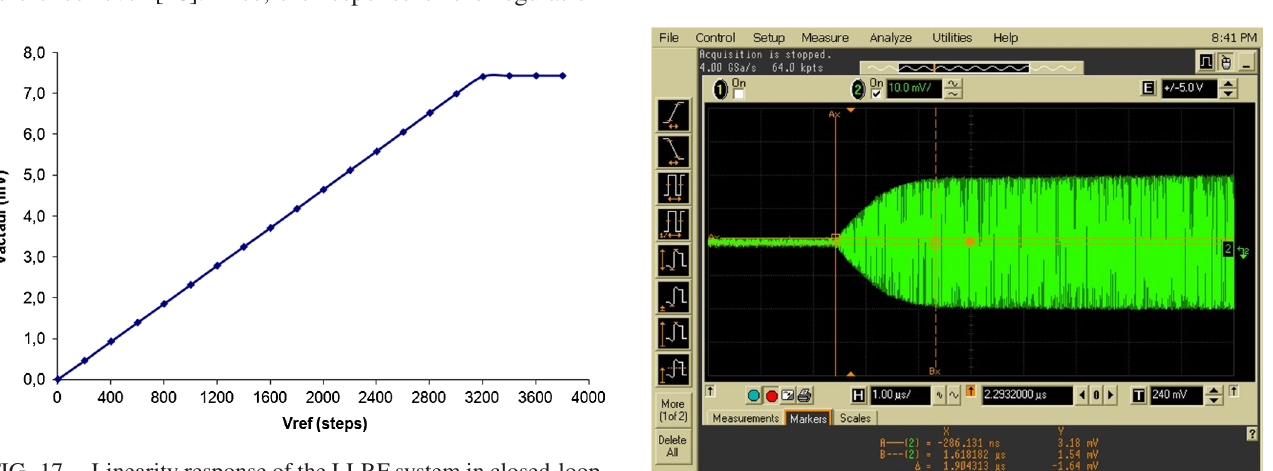
FIG. 17. Linearity response of the LLRF system in closed-loop mode. The horizontal axis is the reference value of the cavity voltage and the vertical one is the actual cavity voltage measured by a spectrum analyzer configured directly in mV unit.